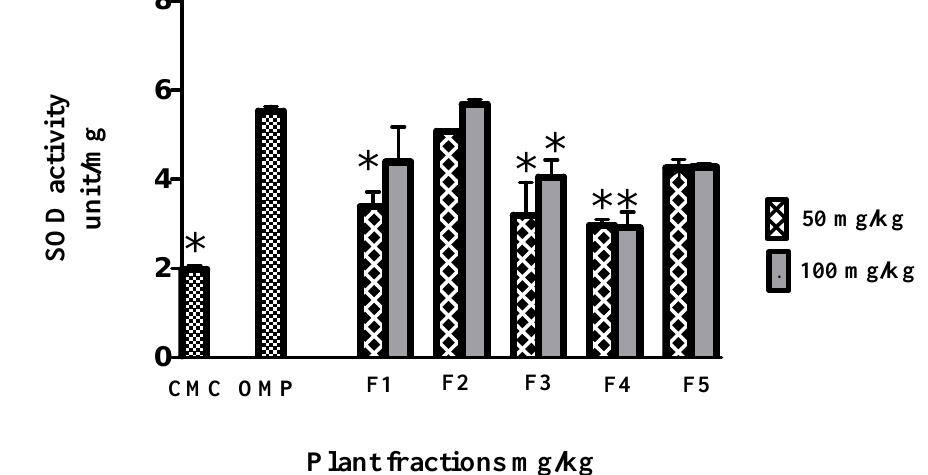
Figure 7. Effect of the fractions obtained from Polygonum minus on the activity of superoxide dismutase (SOD) in the gastric mucosa. Data are expressed as mean ± SEM ( n = 6). * significantly different in comparison to omeprazole, p < 0.05 using one-way